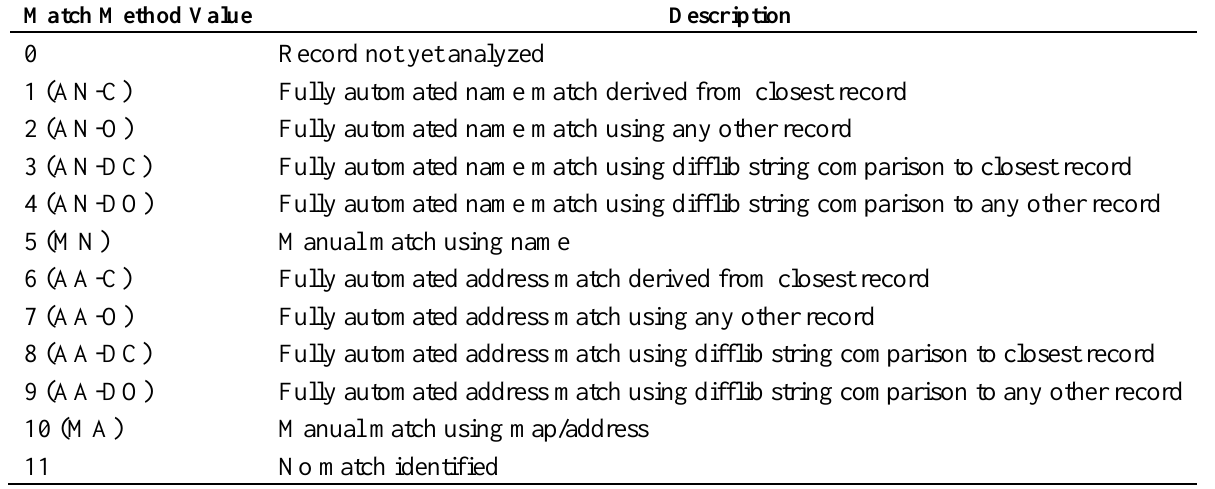
Table 2. Values used to track record